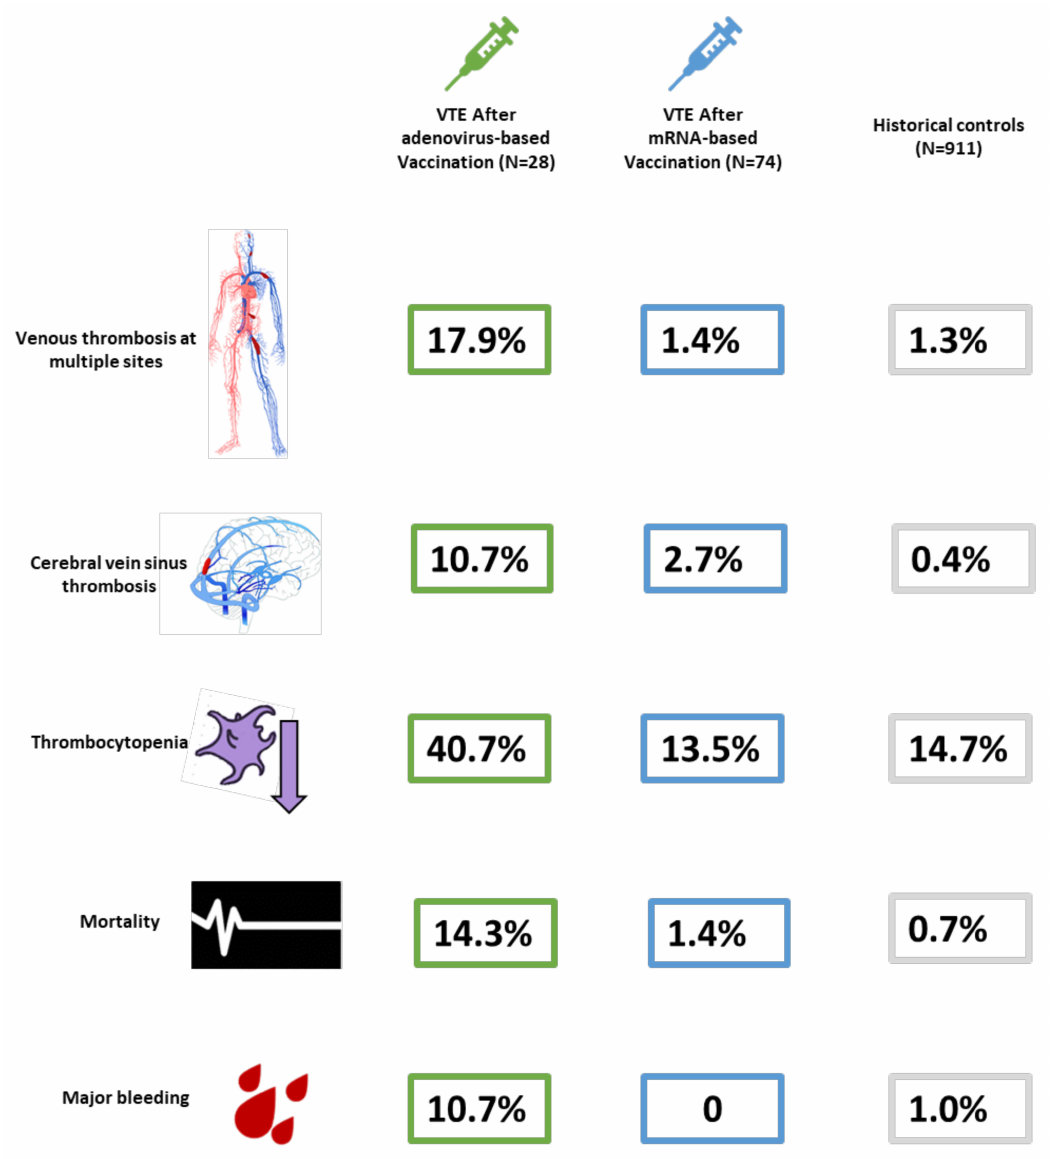
Figure 2. Main Features of Presentation and Outcomes in the Study Groups. N means sample